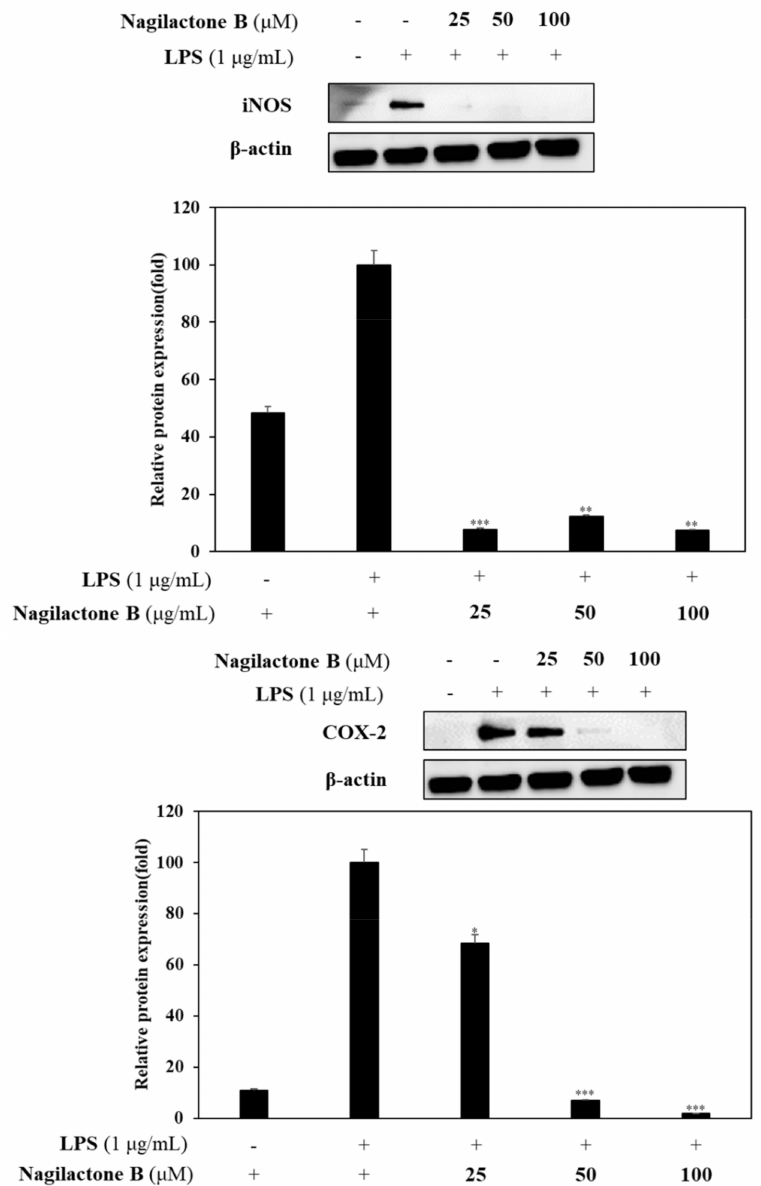
Figure 5. Effects of nagilactone B on iNOS and COX-2 expression. RAW 264.7 cells were incubated in the presence of compounds (25, 50, and 100 µ M) for 1 h and induced with LPS (1 µ g/mL) for 16 h. The levels of iNOS, COX-2, and β -actin in the LPS-stimulated cells were analyzed by western blot analysis. Relative density was calculated as the ratio of the expression level of each protein with β -actin. * p < 0.05, ** p < 0.01, *** p < 0.001 vs. LPS-treated